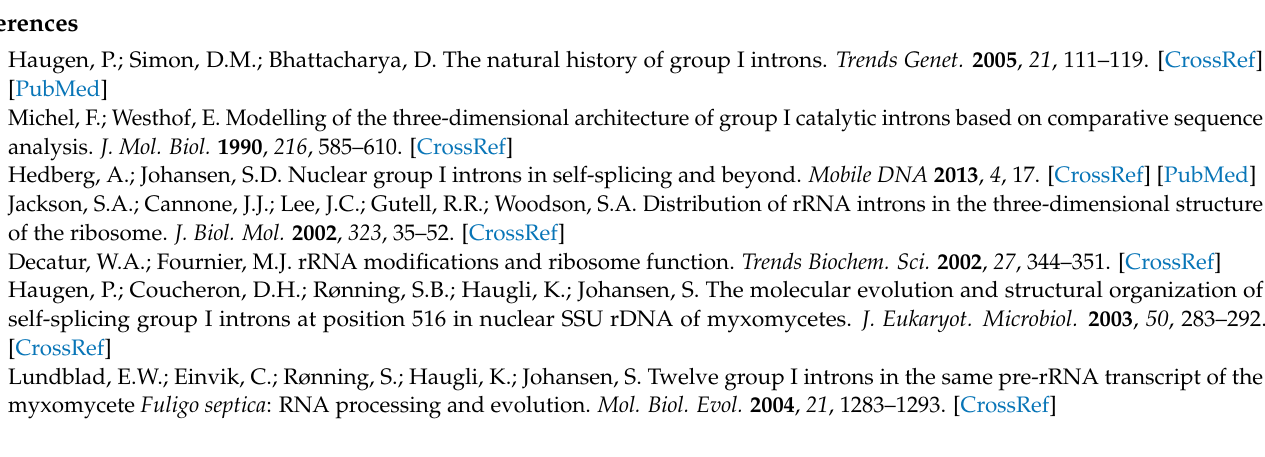
the fraction of substitutions per site. Figure S4: Two closely related Meriderma species contain distantly related S516 group I introns. (a) Secondary structure diagram of M. aggregarum S516 intron RNA. (b) Secondary structure diagram of M. cribrariodes S516 intron RNA. Peripheral regions with signifi- cant structural differences are boxed. Figure S5: (a) Structural features of homing endonuclease genes (HEG)-containing S516 group I intron in Lamproderma pseudomaculatum . (b) Nucleotide sequence of HEG, including the 58-nt spliceosomal intron (red letters). Start (ATG) and stop (TAA) codons are indicated, as well as the polyadenylation signal (AATAAA). (c) Amino acid sequence of the homing endonuclease. Important residues involved in Zn binding (red) and catalysis (blue) are indicated. Figure S6: (a) Structural features of homing endonuclease genes (HEG)-containing S516 group I intron in Echinostelium coelocephalum . (b) Nucleotide sequence of HEG, including the 59-nt spliceosomal intron (red letters). Start (ATG) and stop (TAA) codons are indicated, as well as the polyadenyla- tion signal (AATAAA). (c) Amino acid sequence of the homing endonuclease. Important residues involved in Zn binding (red) and catalysis (blue) are indicated. Figure S7: (a) Structural features of homing endonuclease genes (HEG)-containing S516 group I intron in Trichia varia . (KM494993-5). (b) Nucleotide sequence of HEG, including the 50-nt spliceosomal intron (red letters). Start (ATG) and stop (TGA) codons are indicated, as well as the polyadenylation signal (AATAAA). (c) Amino acid sequence of the homing endonuclease. Important residues involved in Zn binding (red) and catalysis (blue) are indicated. Figure S8: Sequence alignment of direct repeat motifs in myxomycete S516 group I intron. Direct repeats are located in peripheral regions P1, P2, P5, P6, P8, and P9. Figure S9: RNA structural support of HEG deletion in Trichia varia S516 group I introns. HEG deletion in segment P2 (KM494996) leaves a HEG remnant sequence corresponding to the 5 (cid:48) end of the open reading frame (indicated by green colored nucleotides), as well as a direct repeat feature (DR-1 and DR-2). Only paired segments P1 and P2 are shown. Table S1: Key features of 75 nucleolar group I introns at position S516 in myxomycete. Table S2: Schematic organization of direct repeats arrays in S516 group I introns in